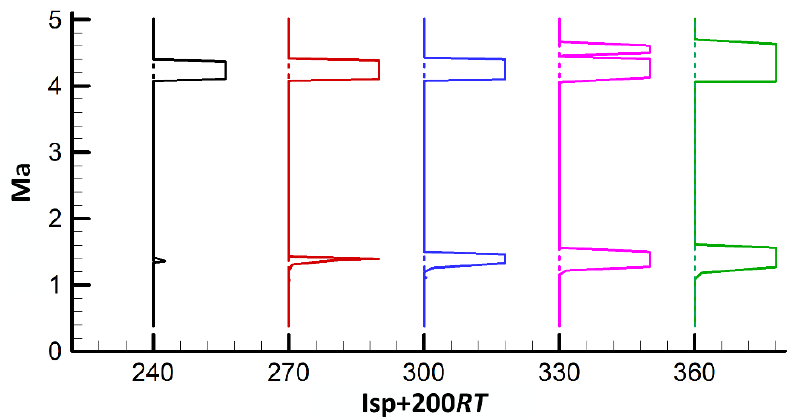
Figure 14. Rocket RT profiles under different rocket Isp (AF D = 1.1).